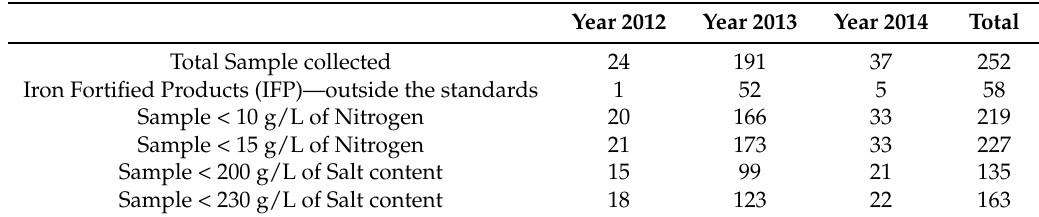
Table 1. Samples collected between October 2012 and February 2014.